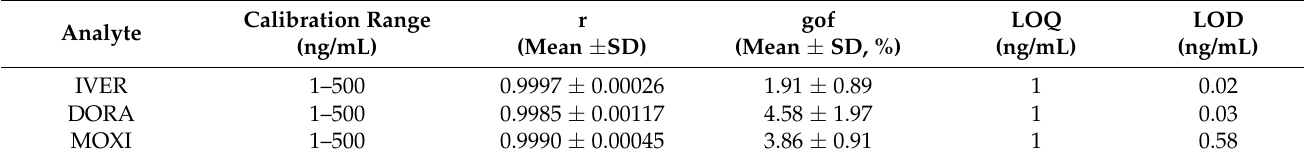
Table 2. Results of the evaluation of the calibration model (correlation coe € cient (r) and goodness-of- fit coefficient (GoF), mean + standard deviation, ( n = 3), the limit of quantification (LOQ), and limit of detection (LOD) for IVER, DORA, and MOXI in bovine